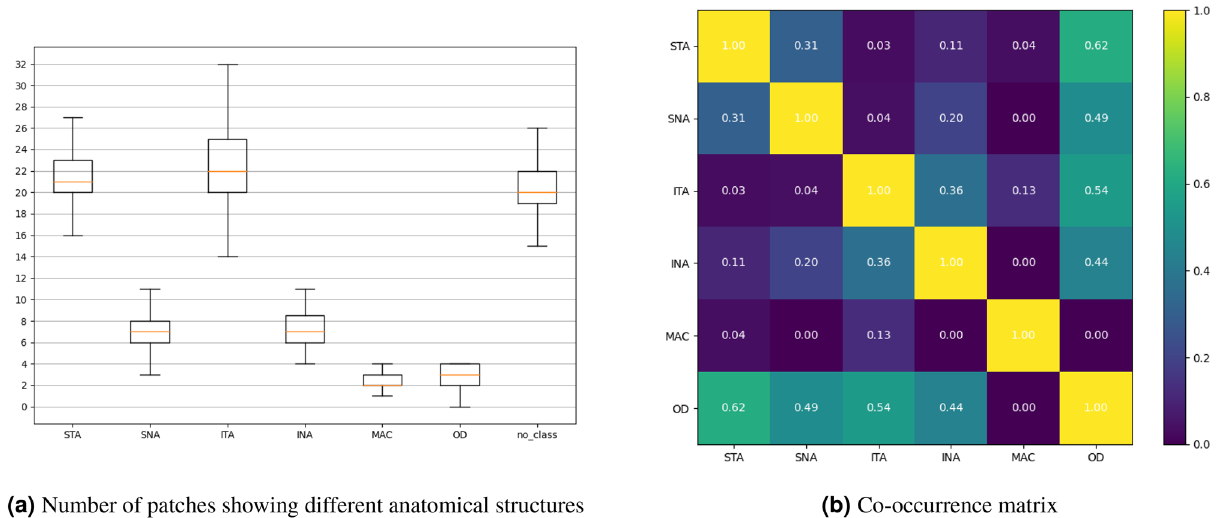
Figure 2. The boxplot diagram ( a ) illustrates the number of image patches for the different anatomical structures across all 135 eye examinations. The co-occurrence matrix of anatomical structures within one patch is displayed in ( b ). When two or more classes are visible in one patch their appearance is counted in the matrix. Next, the matrix is normalized to range between 0 and 1 by an intersection over union norm. Class legend: S/I superior/inferior, T/N temporal/nasal, A arcade, MAC macula, OD optic